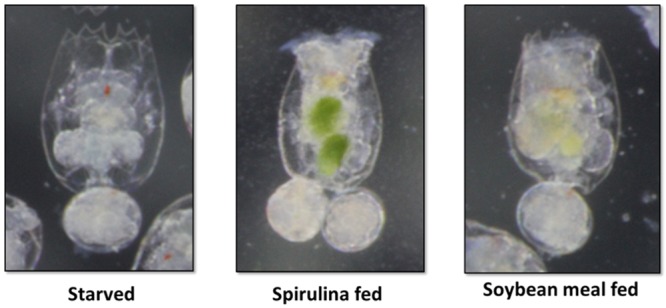
Rotifers after 2 hours of enrichment with Spirulina or ground, blended, and sieved soybean meal.